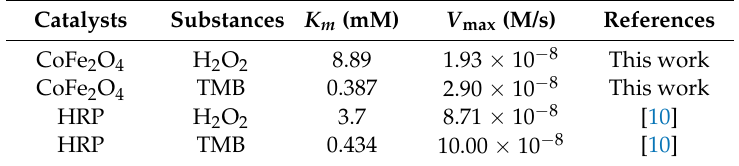
Table 2. Comparison of K m and V max between CF300 and HRP for H 2 O 2 and TMB. Catalysts Substances